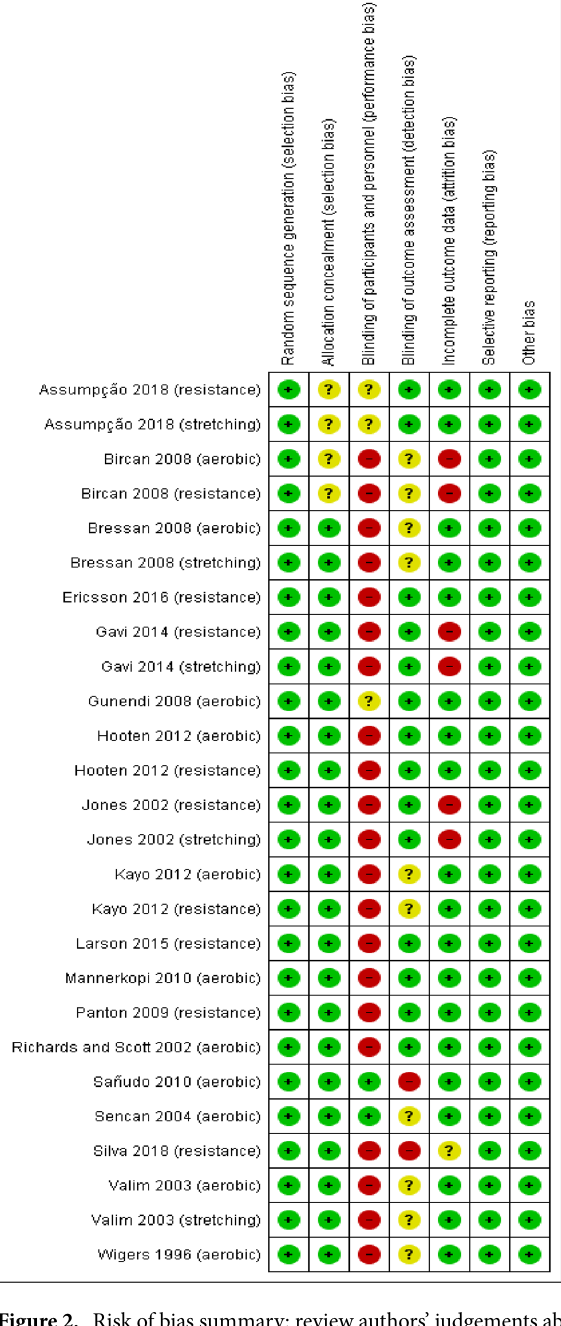
Figure 2. Risk of bias summary: review authors’ judgements about each risk of bias item for each included